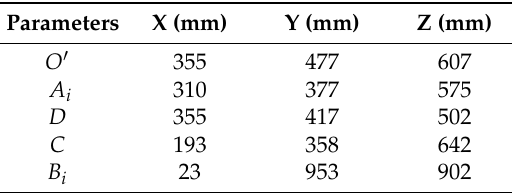
Table 3. Position of relevant parts.